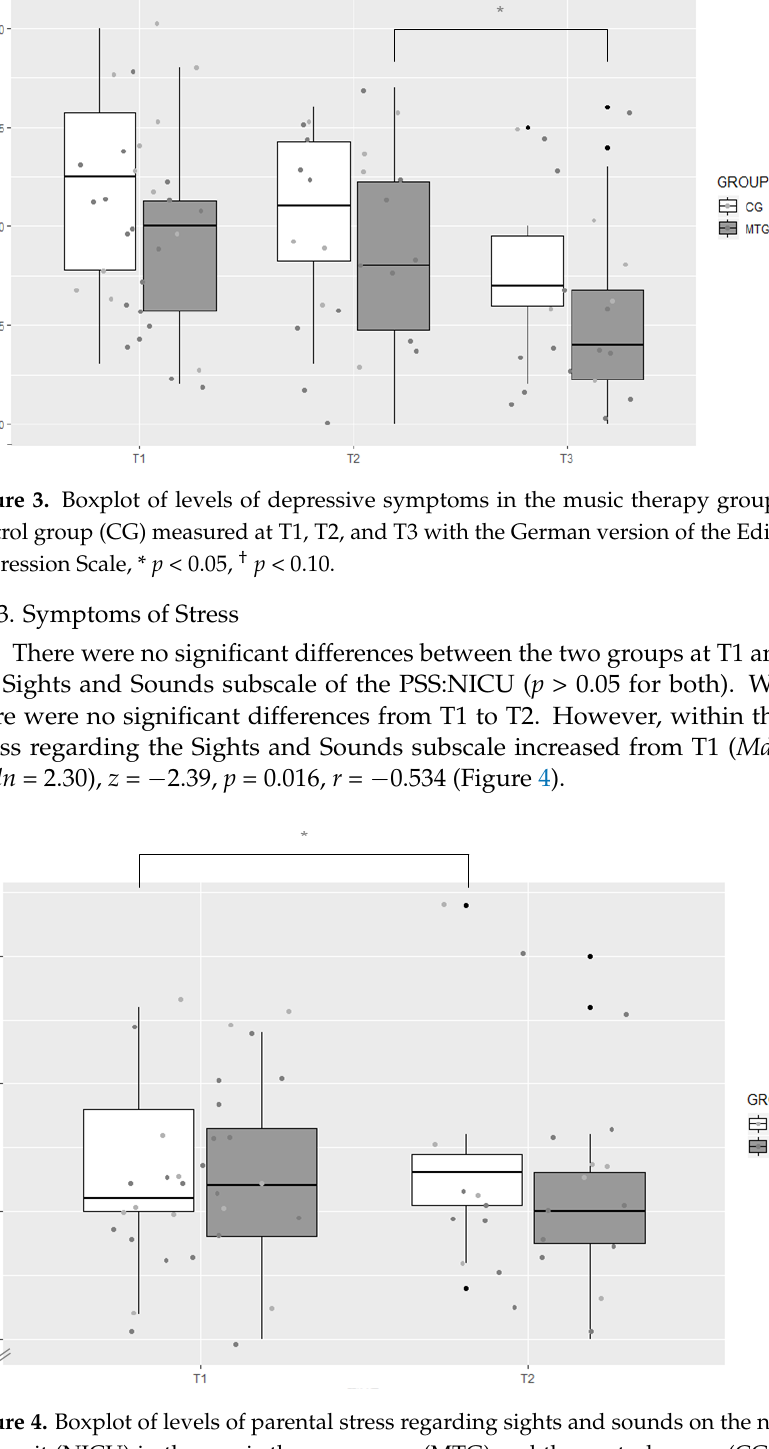
Figure 4. Boxplot of levels of parental stress regarding sights and sounds on the neonatal intensive care unit (NICU) in the music therapy group (MTG) and the control group (CG) measured at T1 and T2 with the German version of the Sights and Sounds subscale of the Parental Stressor Scale: Neonatal Intensive Care Unit (PSS:NICU), * p < 0.05.